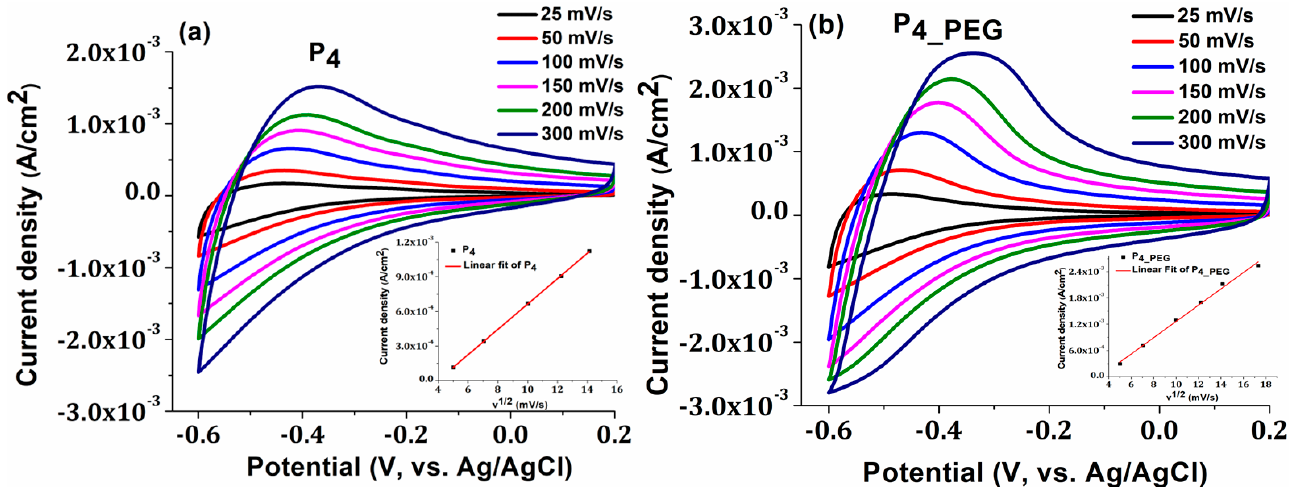
Figure 8. The cyclic voltammograms of ( a ) P 4 and ( b ) P 4_PEG films on FTO at various scan rates, with an insert displaying the plot of oxidation peak current densities vs. square root of potential scan rate.